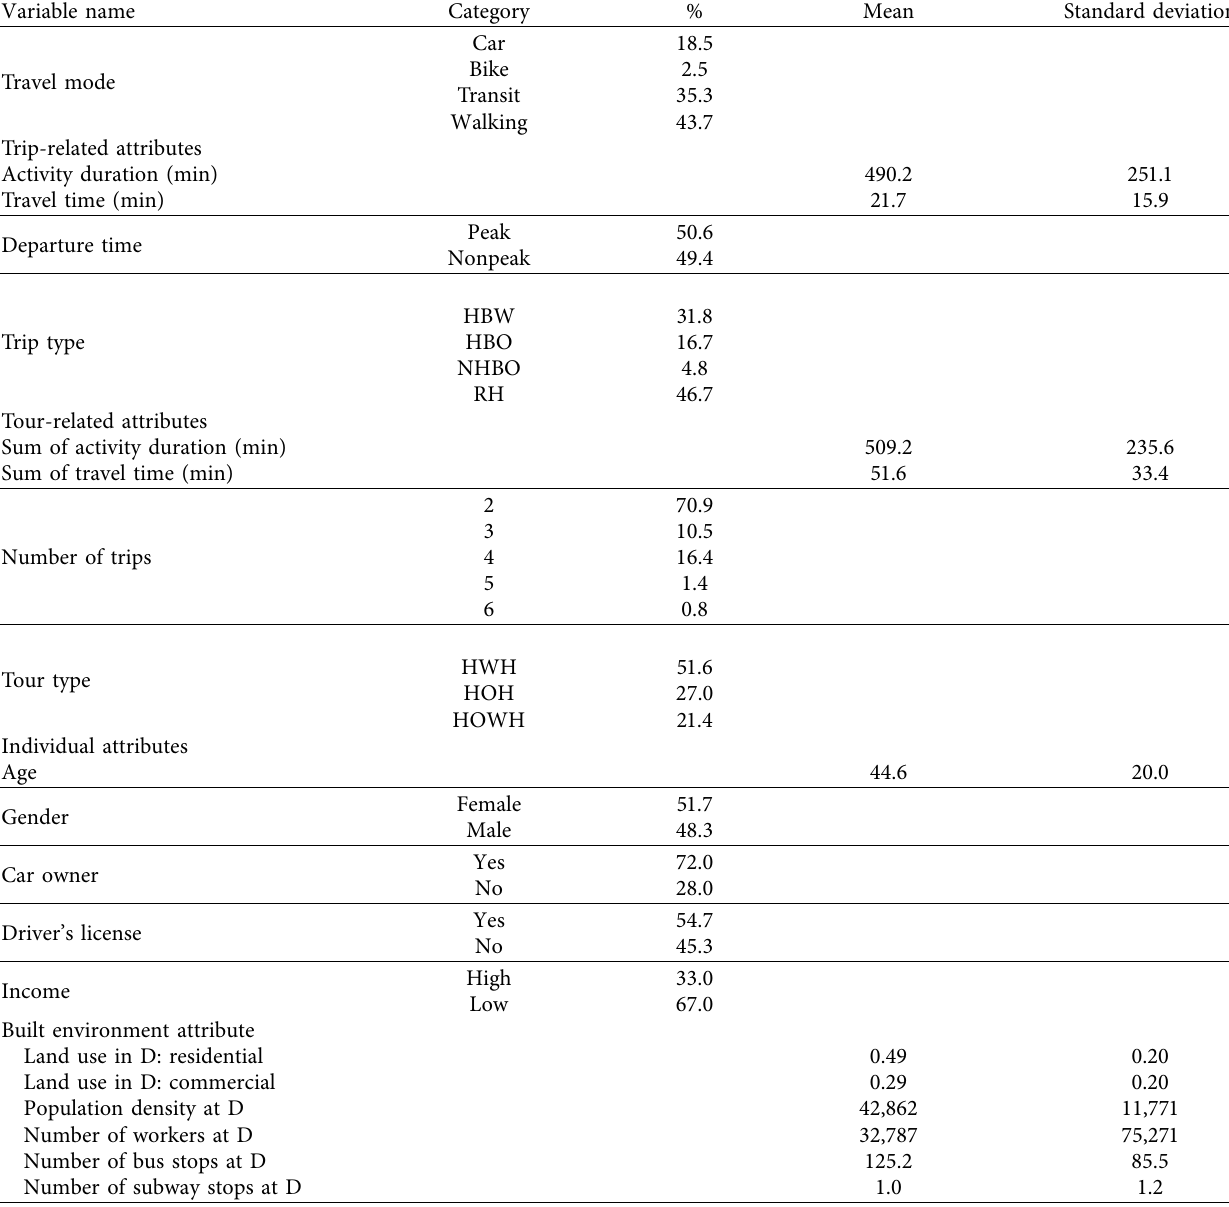
Table 2: Descriptive statistics of the